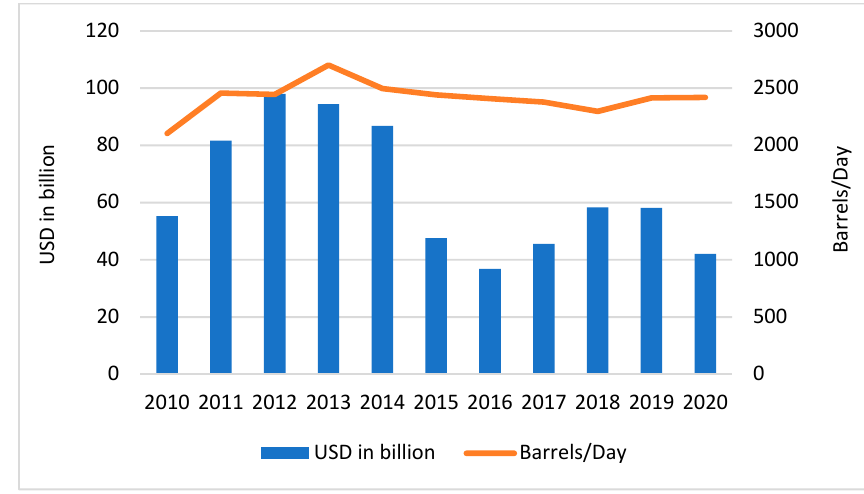
Figure 8. The UAE’s energy trade: crude oil export. Based on the CEIC data [29]. Most of the UAE oil was exported to Asia. Almost the whole of Europe, especially 3SI countries, were not recipients of it (Figure 9). Based on Autoregressive Distributed Lag (ARDL), AlKhars, Miah, Qudrat-Ullah, and Kayal underline that economic growth is related to energy consumption in the United Arab Emirates [30] (p. 15). Critically judging, one should agree with the results of the Jaradat and Al-Tamimi research (also based on the ARDL)—that there is a statistically significant relationship between renewable energy and the economy in the United Arab Emirates [31] (p. 161).